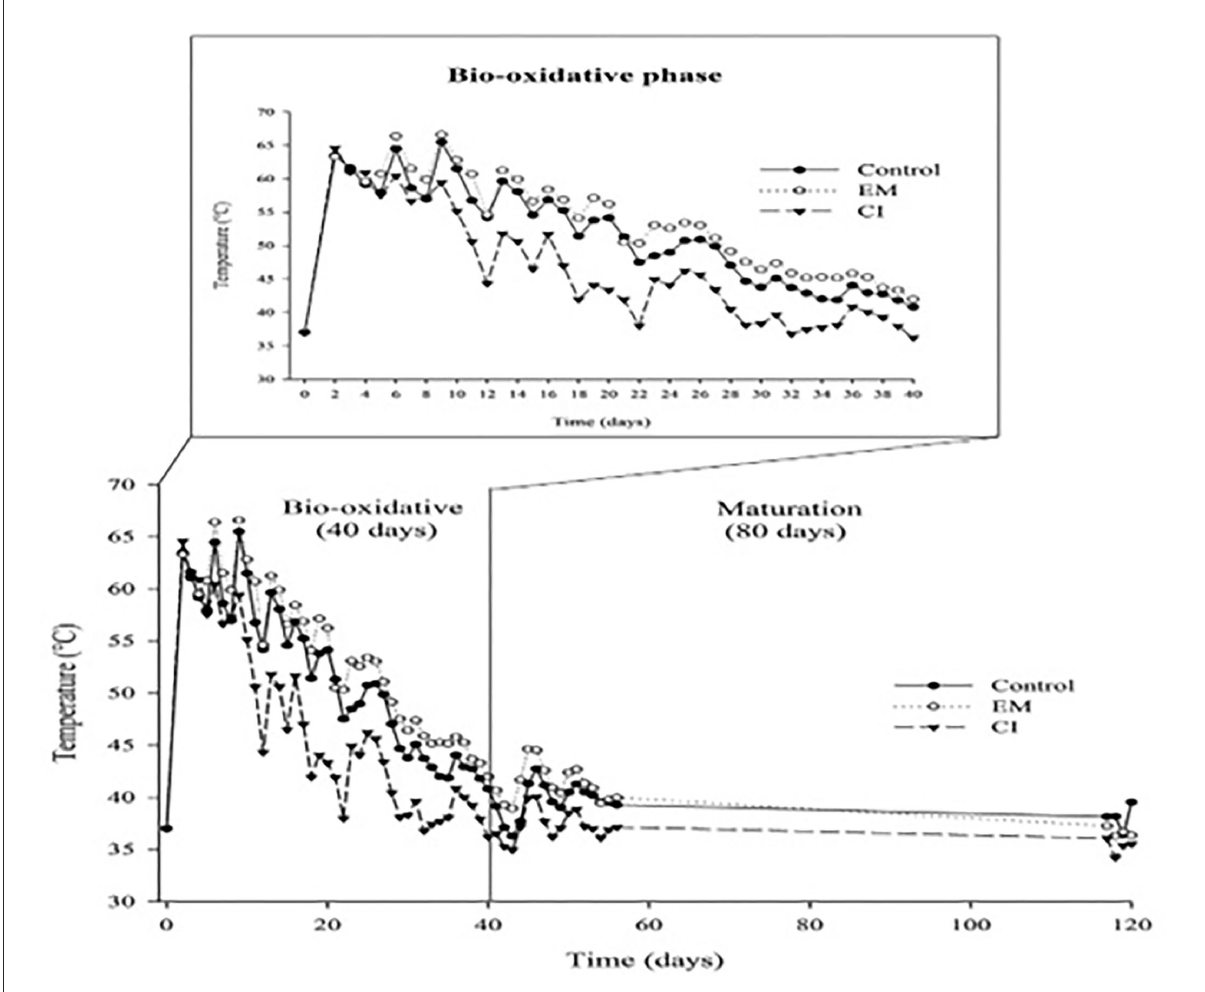
FIGURE2 Thermal profile ( ◦ C) of the three treatments Control; Efficient microorganisms (EM) and commercial inoculum (CI) during the composting process.